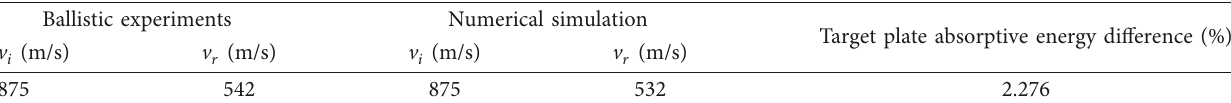
Table 6: Comparison of target plate absorptive energy in the numerical simulation and ballistic tests.